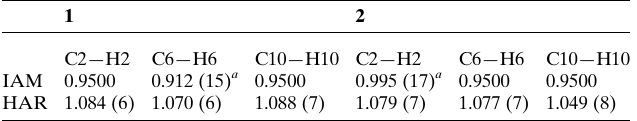
Table 5 C—H bond length (A˚ ) of the methine groups for IAM and HAR for compounds 1 and 2